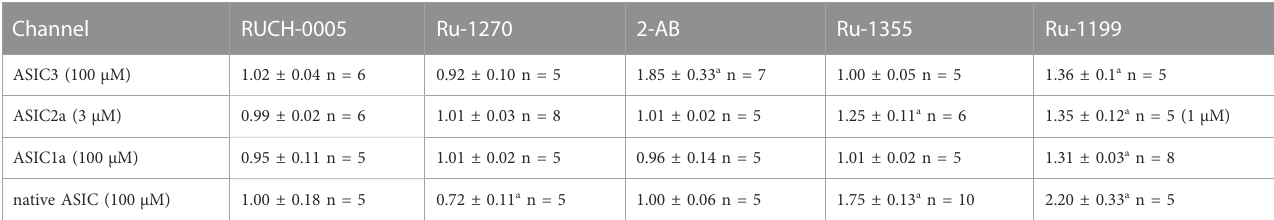
TABLE 1 Activities of 2-aminobenzimidazole derivatives (drug vs. control). Channel